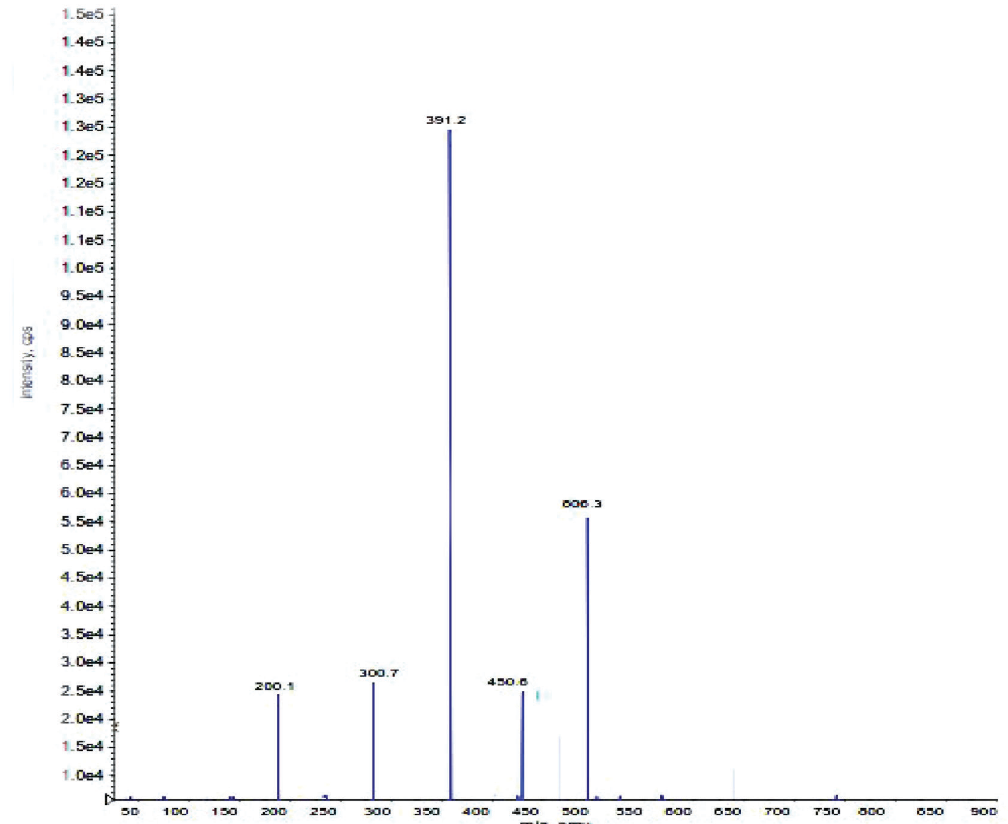
FIGURE 4 - Parent and product ion mass spectra of